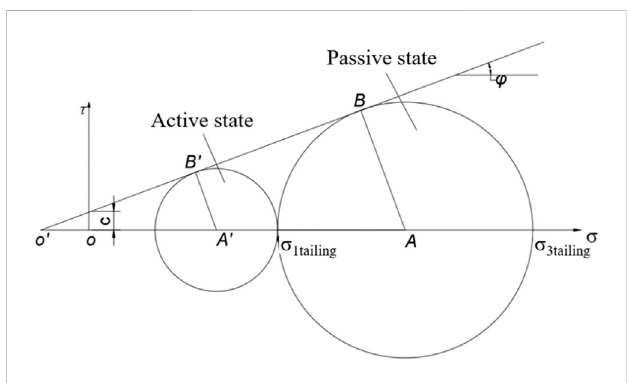
FIGURE 11 Limit equilibrium analysis of tailings in the passive